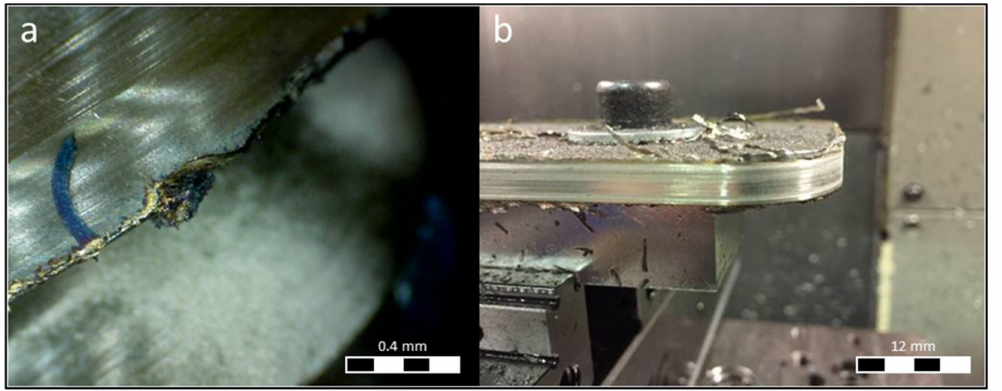
Figure 3. Notch wear in the ceramic tool ( a ) and surface finish of the workpiece after 5000 mm ( b